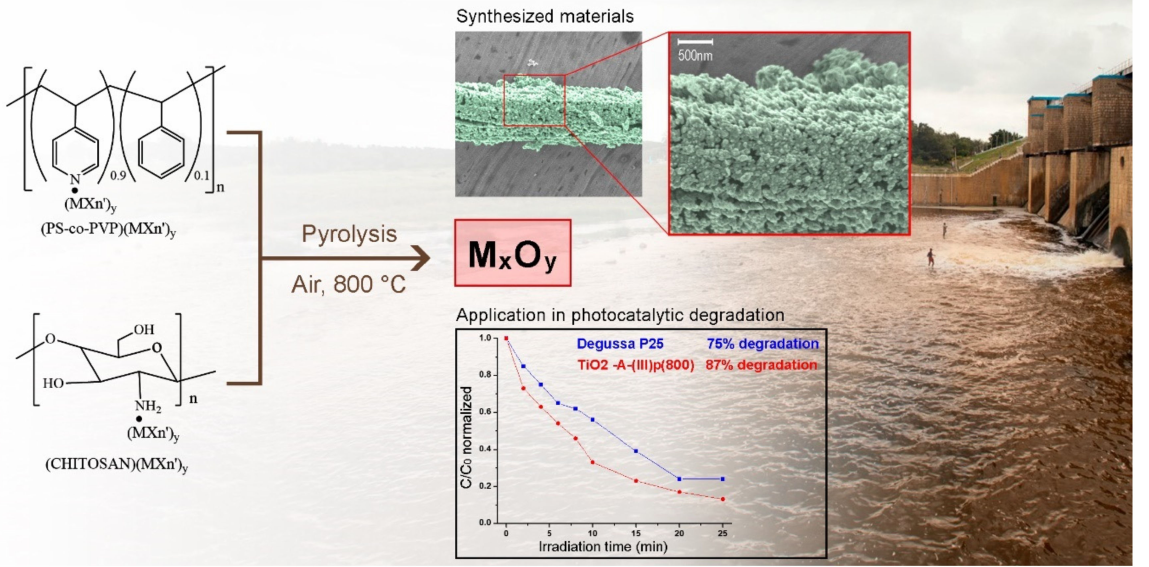
Figure 1. Schematic representation of the solid-state method and its application in environmental